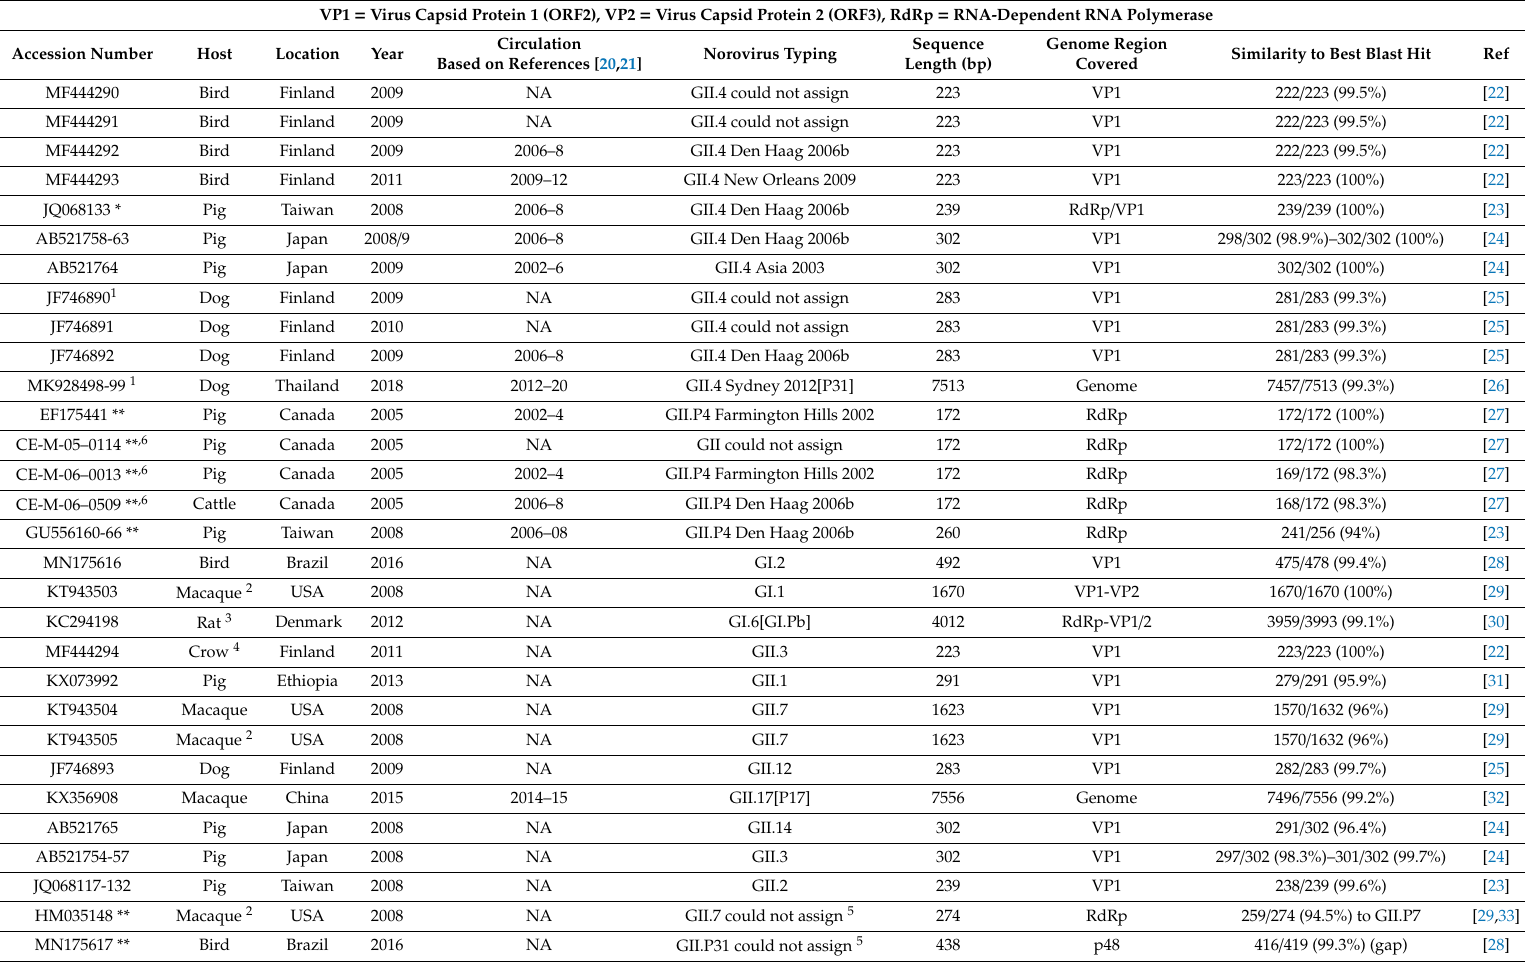
Table 1. Information about human norovirus sequences found in